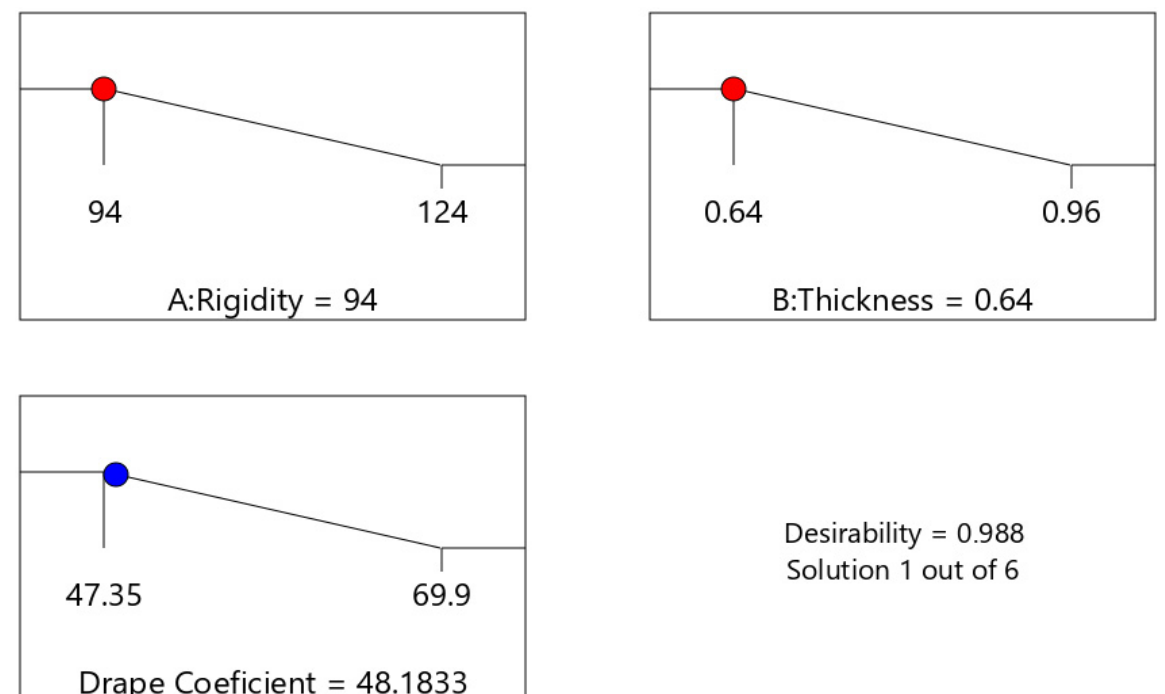
Figure 5. Variables optimization with lower and maximum bounds.